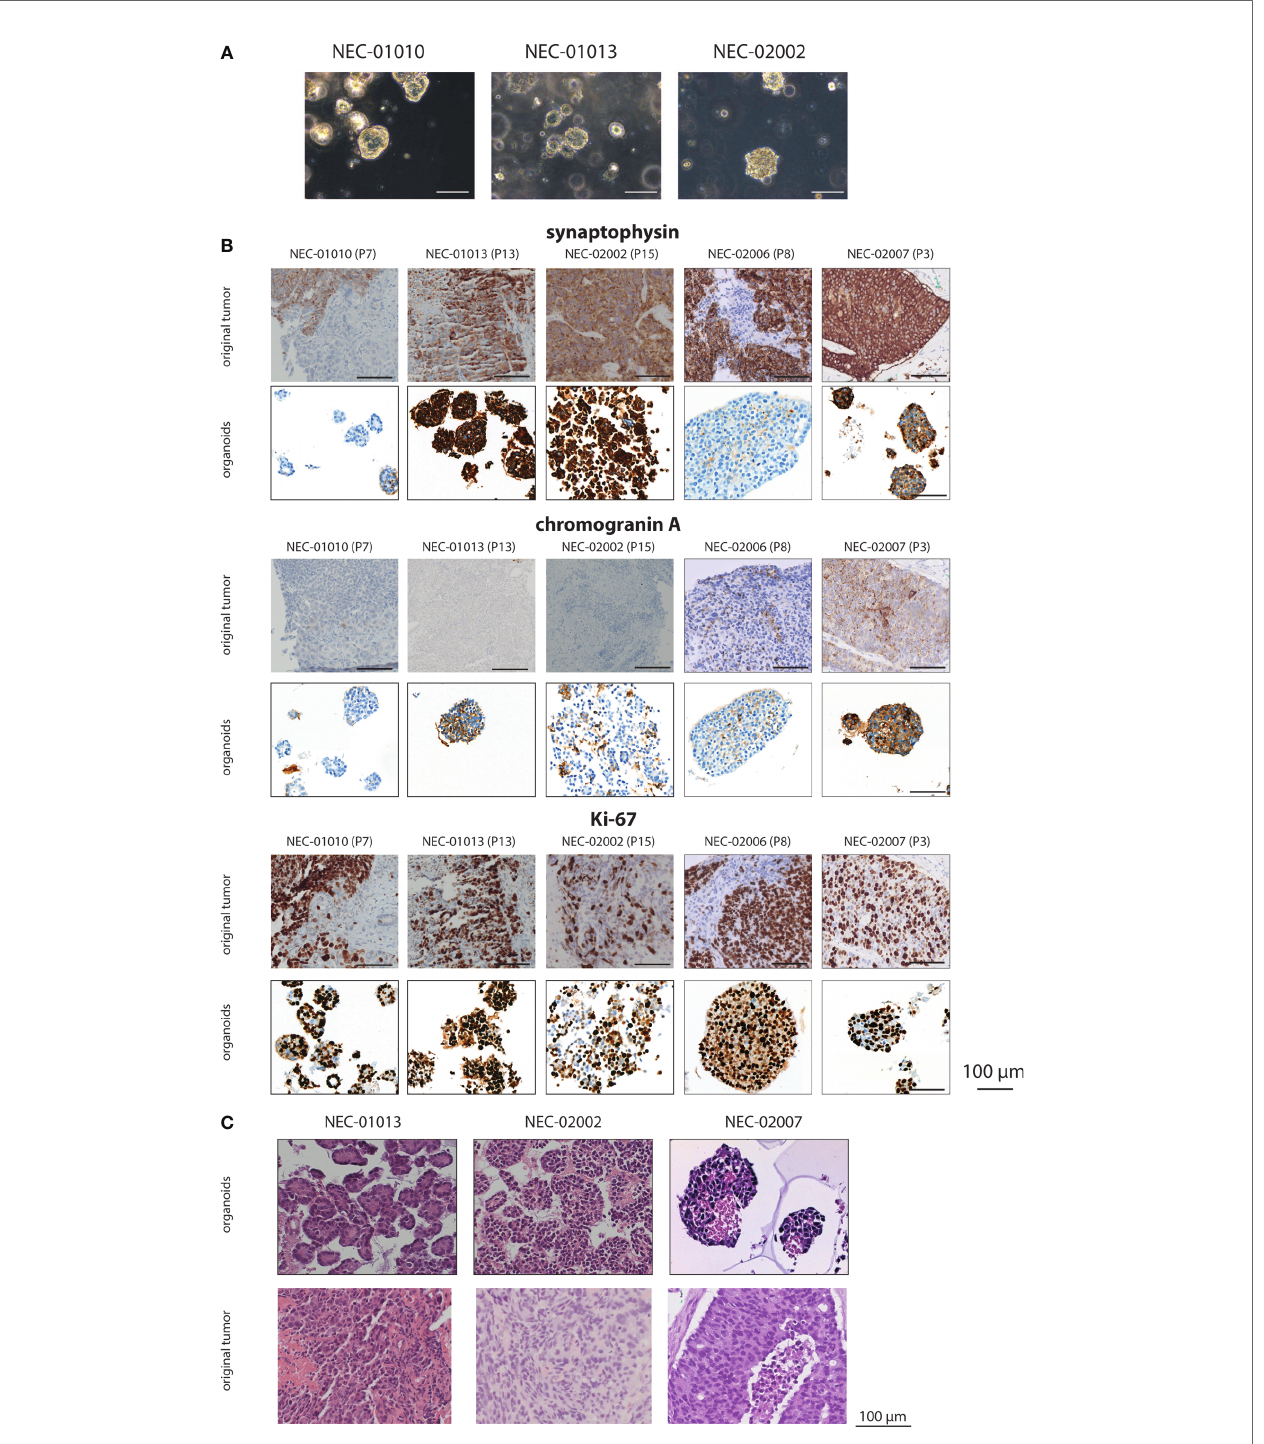
FIGURE 1 | Histomorphology of GEP-NEC organoid lines and matching original tumor. (A) Phase-contrast photomicrographs of GEP-NEC organoid lines. Scale bar = 100 µm. (B) Immunostainings of synaptophysin, chromogranin and Ki-67 for organoids and original tumor. P7 indicates passage 7. (C) Hematoxylin and eosin (H&E) stained slides of GEP-NEC organoid lines and original tumors. NEC-01013: passage (P) 12; NEC-02002: P20; NEC-02007: